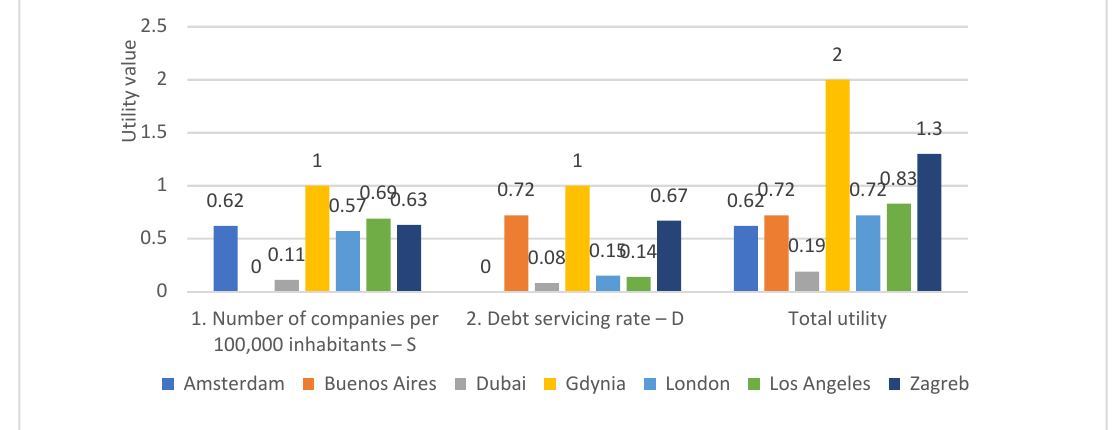
Figure 2. Partial and total utility for the economic dimension indicators.